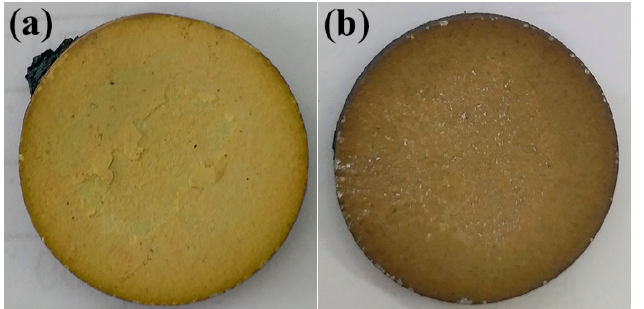
Figure 11. The macro-image of the failed coatings after thermal shock test: ( a ) LC/YSZ after 68 thermal cycles, and ( b ) LGC/YSZ after 109 thermal cycles.